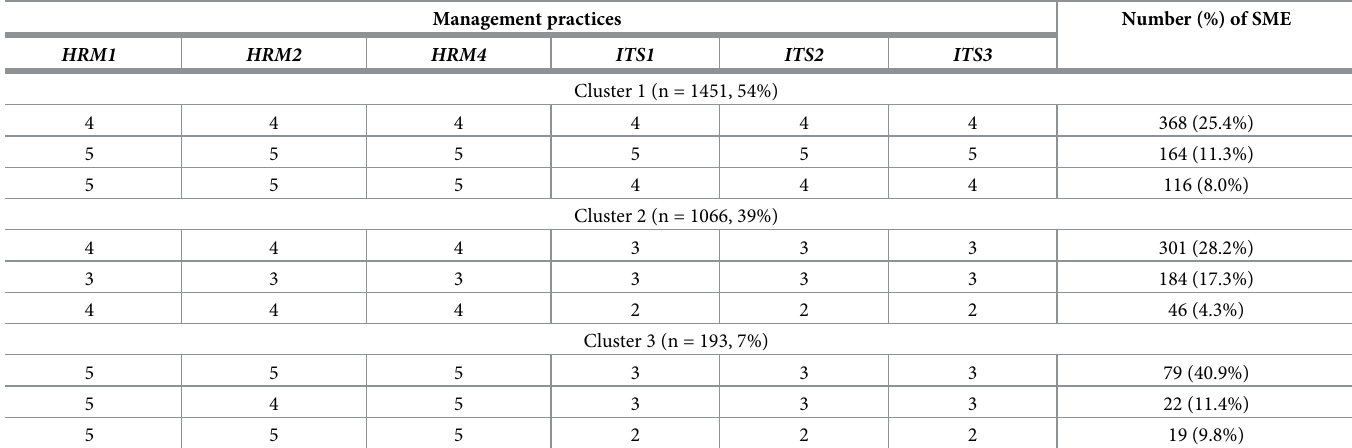
Table 3. The three most frequently indicated by SME response combinations for management practices in each cluster.